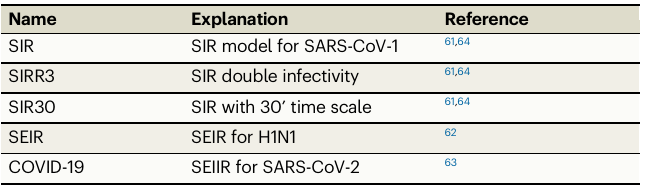
Table 1 | List of abbreviation for the epidemic models here considered and respective reference to the literature for the choice of the epidemic parameters